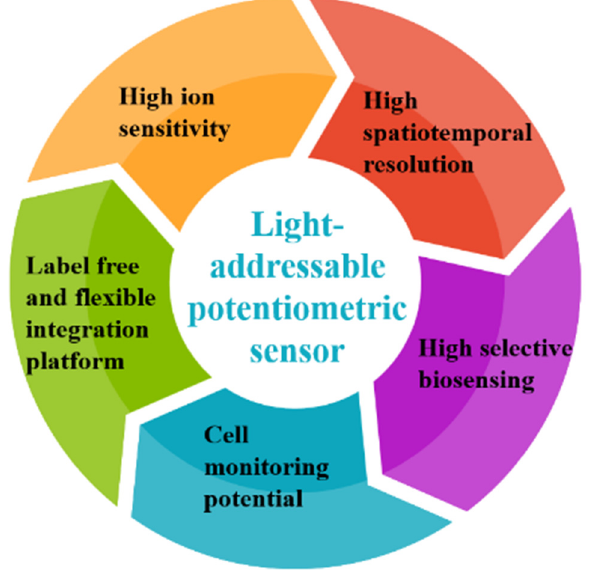
Figure 1. Main advantages of the light ‐ addressable potentiometric sensor.